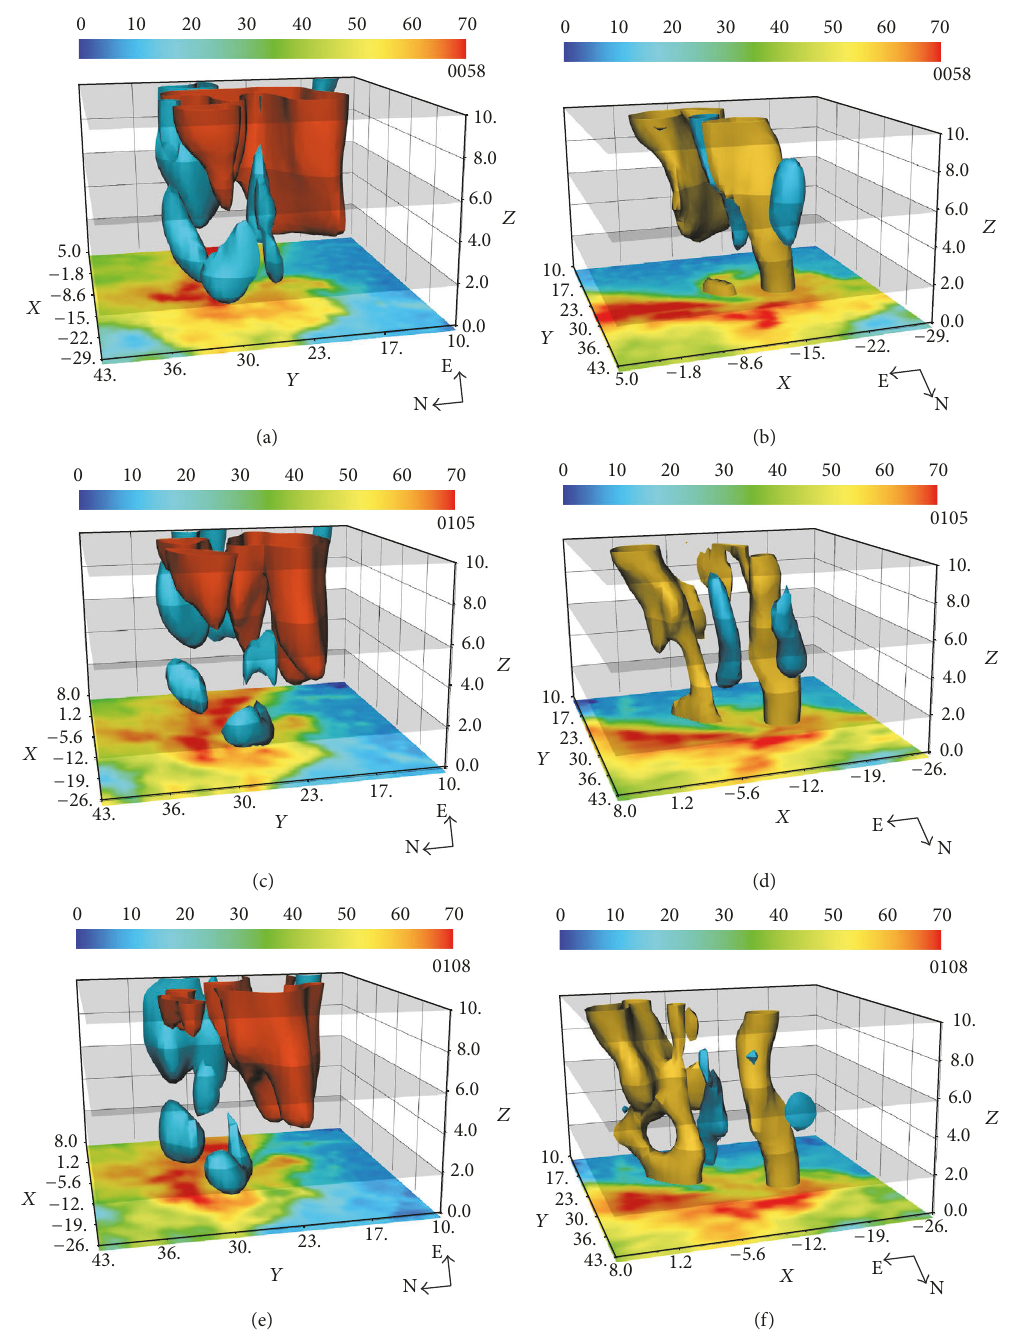
Figure 11: Same as Figure 4, except for during the development stage of the third